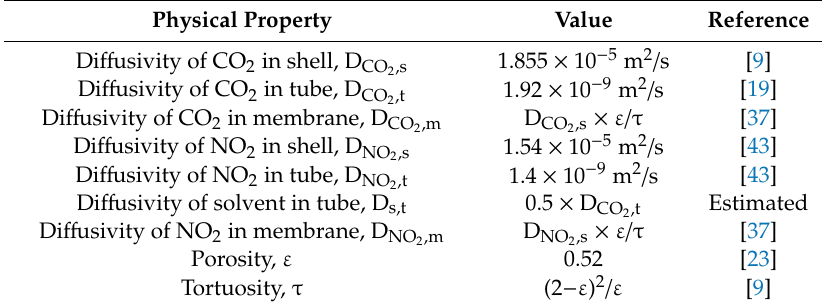
Table 2. Physical properties used in the